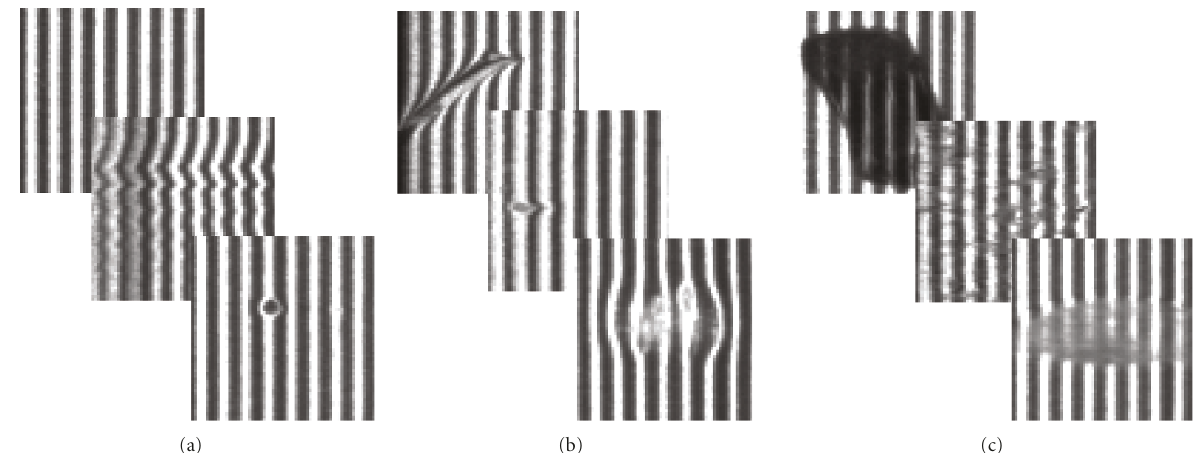
Figure 2: Stripe image examples: (a) three examples of patterns depicting non-defective surfaces, (b) three patterns of defective 3D surfaces and (c) three patterns of defective 2D surfaces. All of the images have a size of [ M u × M v ] = [64 × 64]